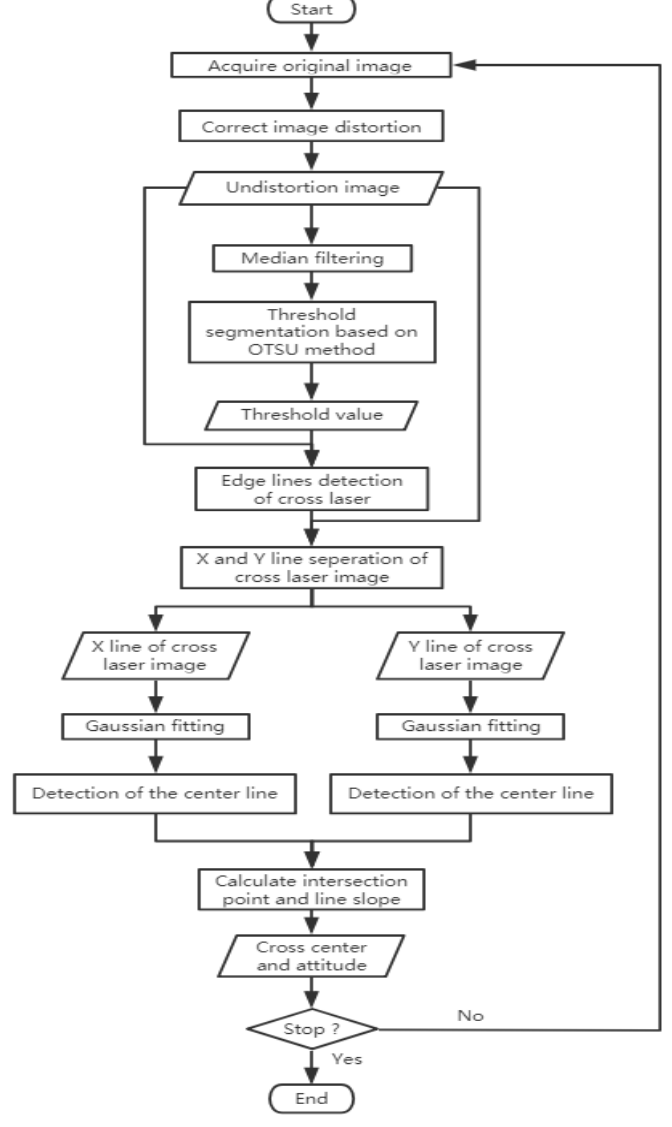
Figure 5. Flowchart of the proposed algorithm.